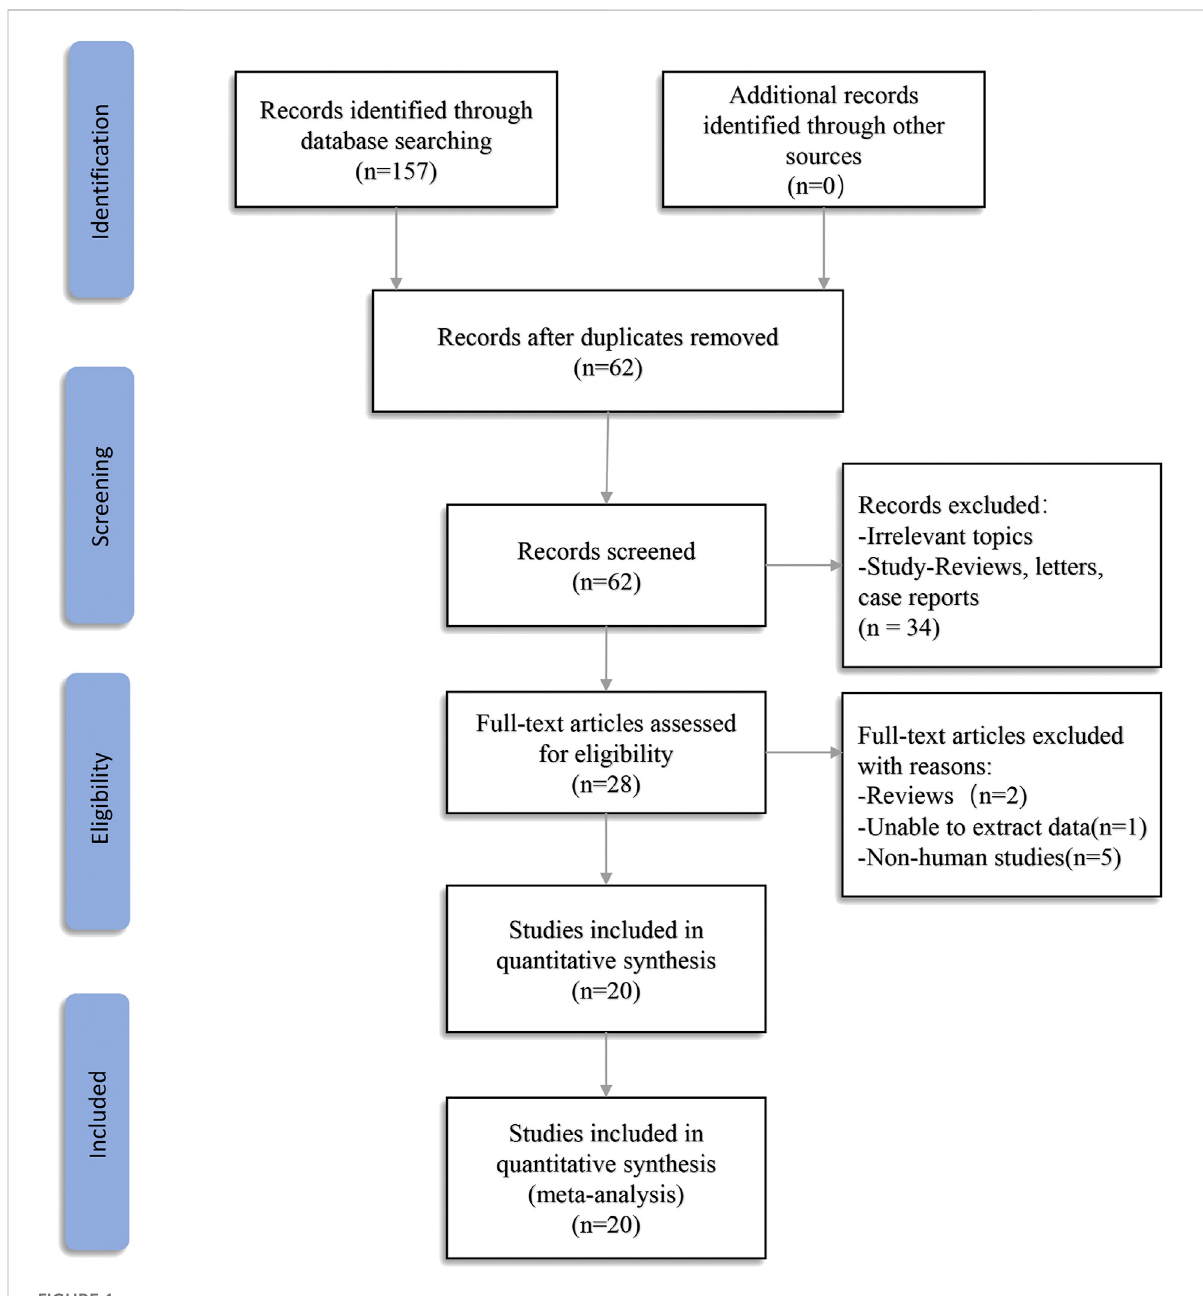
FIGURE 1 Flow diagram of this